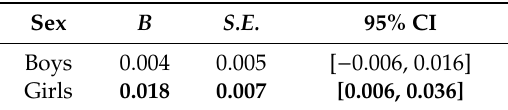
Figure 3. Moderation e ff ect of adolescent sex on the link from T1 mobile phone addiction to T2 self-control. Table 4. The mediation e ff ect of self-control by